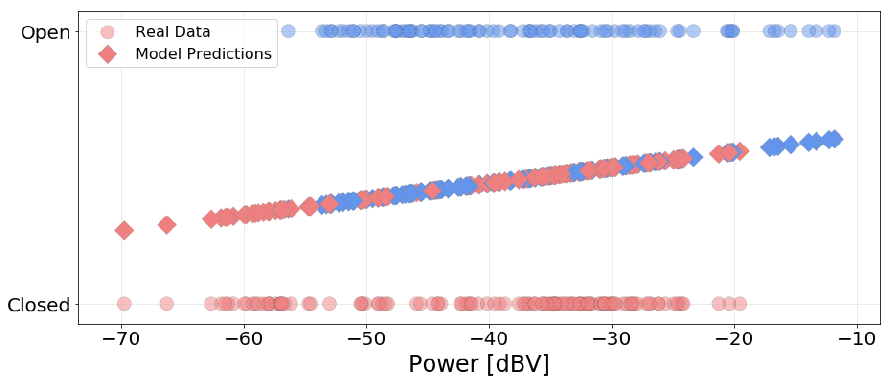
Figure 11. Data grouped by position of windows and predictions using the logistic